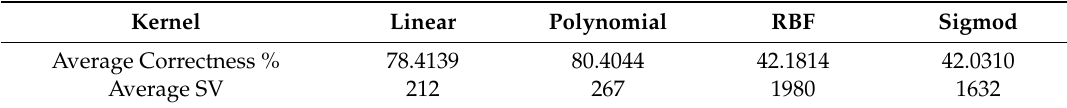
Table 2. Kernel function selection evaluation index.